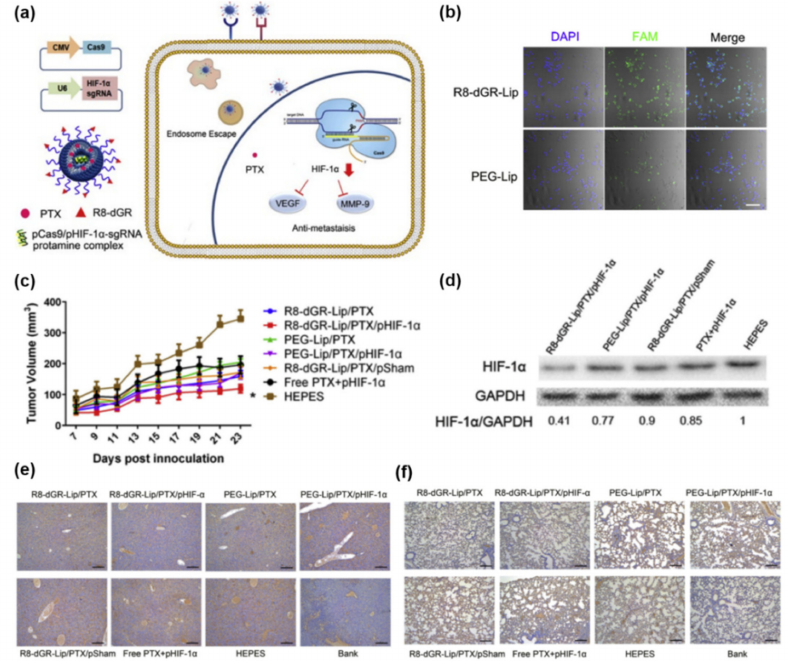
Figure 2. R8-dGR peptide modified and loaded CRISPR/Cas9-HIF-1 α and paclitaxel cationic lipo- some for targeted pancreatic treatment. ( a ) Scheme of the structure of the R8-dGR-Lip/pHIF-1 α and paclitaxel (PTX) delivery in pancreatic cancer cells. ( b ) Cellular internalization of with or without the R8-dGR peptide (Cys-RRRRRRRRdGR) on BxPC-3 cells. scale bar: 100 µ m. ( c ) Tumor volume of BxPC-3 xenograft models treated with different formulations (mean ± SD, n = 10, * p < 0.05). ( d ) In vivo downregulation of HIF-1 α by pHIF-1 α in tumor tissues. ( e , f ) MMP9 expression in liver ( e ) and lung ( f ) of mice. Scale bar: 100 µ m (adapted from Ref.